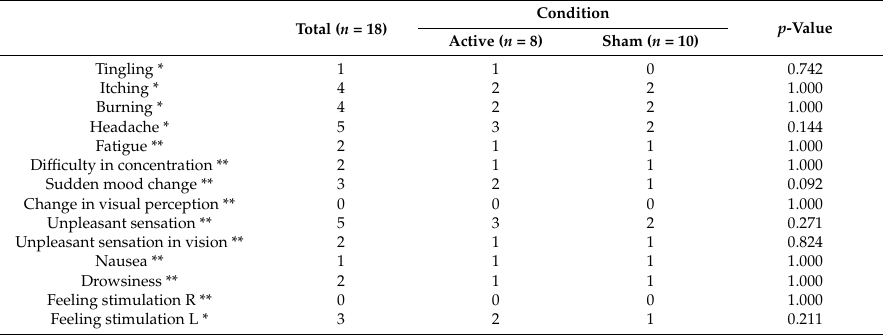
Table 3. Number of occurrences of side effects between active and sham groups for the DLPFC (dorsolateral prefrontal cortex).